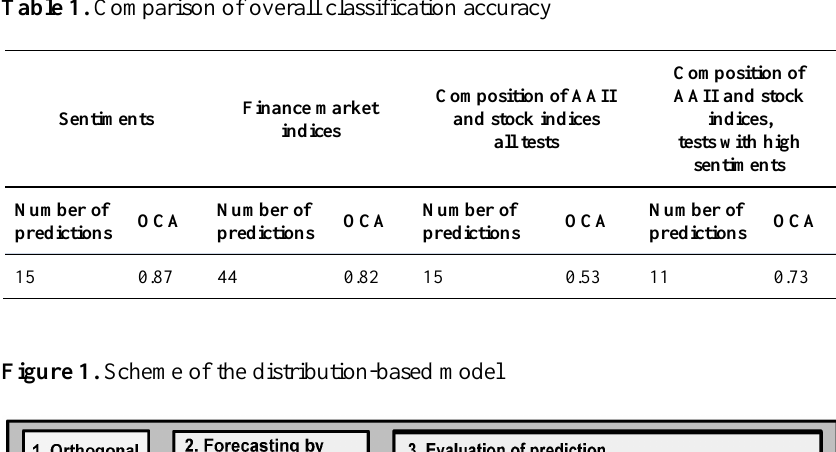
Table 1. Comparison of overall classification accuracy